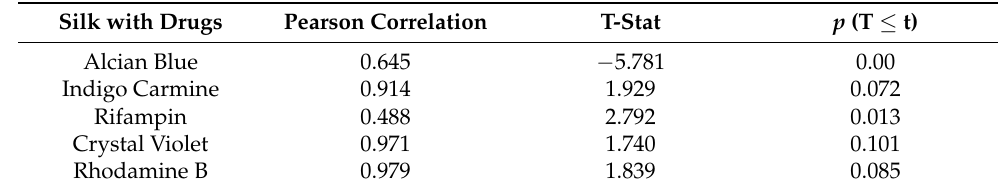
Table 2. Statistical values from model drug release. All probabilities are compared with a two-tailed t critical of 2.120 and an alpha significance level of